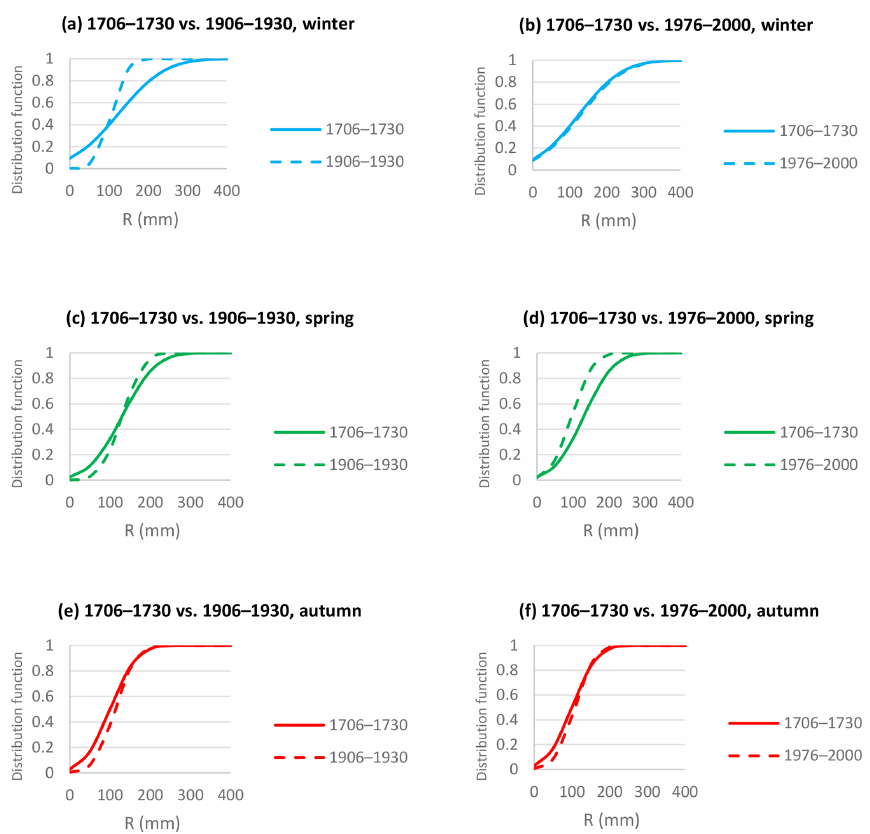
Figure 5. Distribution functions of seasonal rainfall of 1706–1730 and comparison with 1906–1930 (a, c, e) and 1976–2000 (b, d, f) .